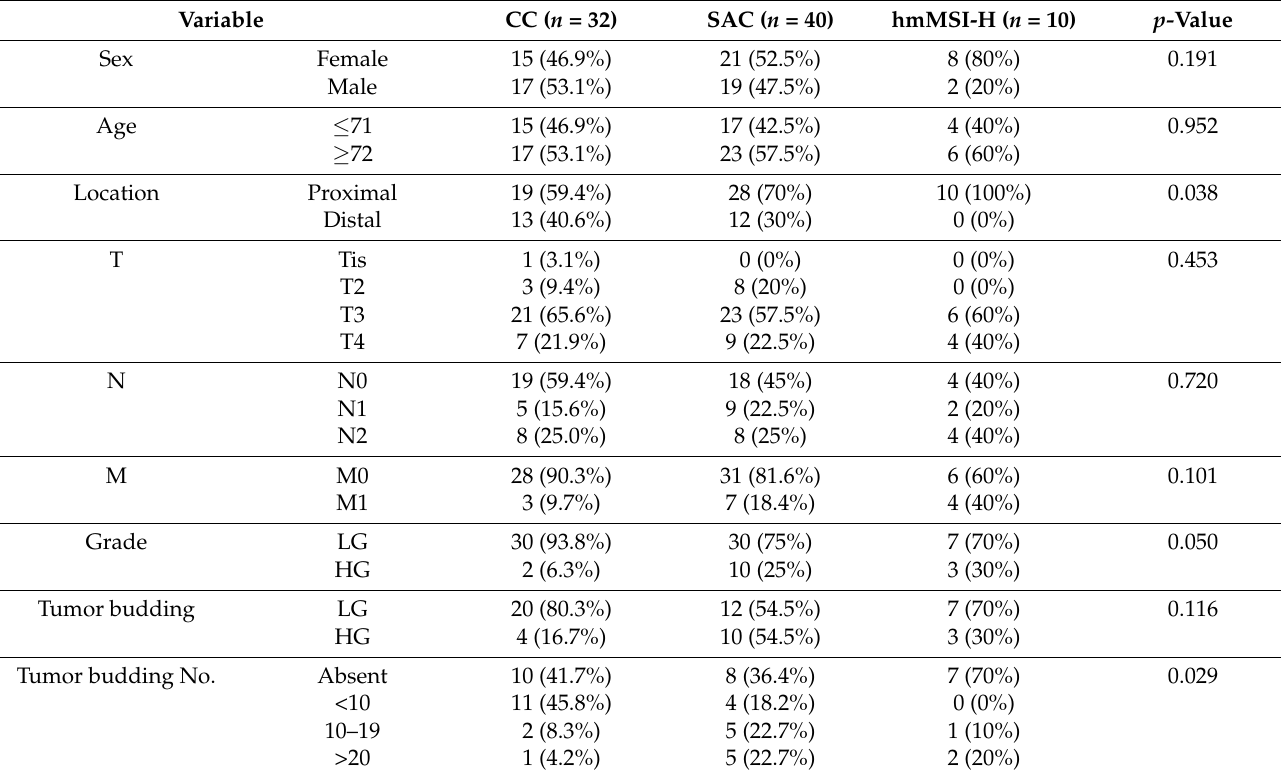
Table 1. Demographic, pathological and molecular characteristics of the study population according to tumor